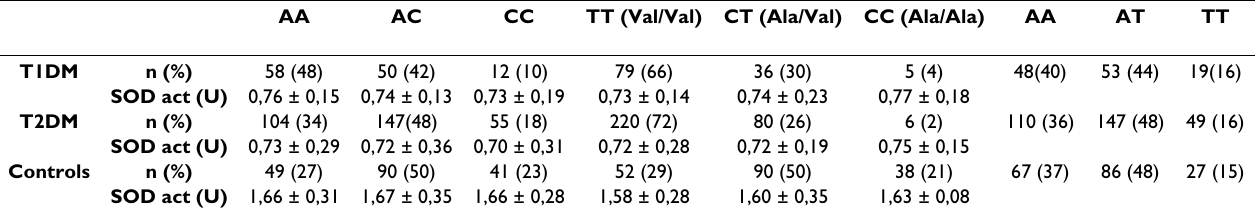
Table 3: SOD activities according to genotype, genotypes